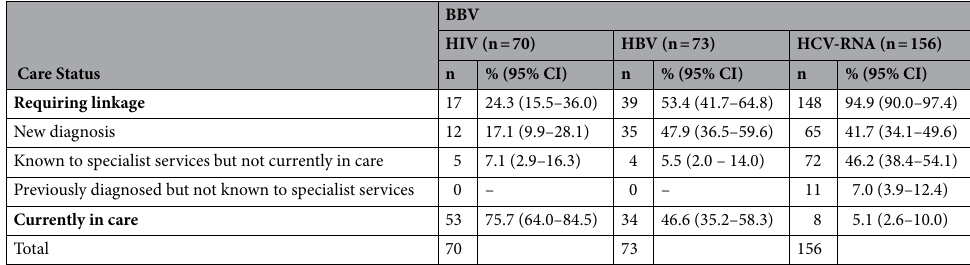
Table 2. Care status of BBV-positive patients at the time of